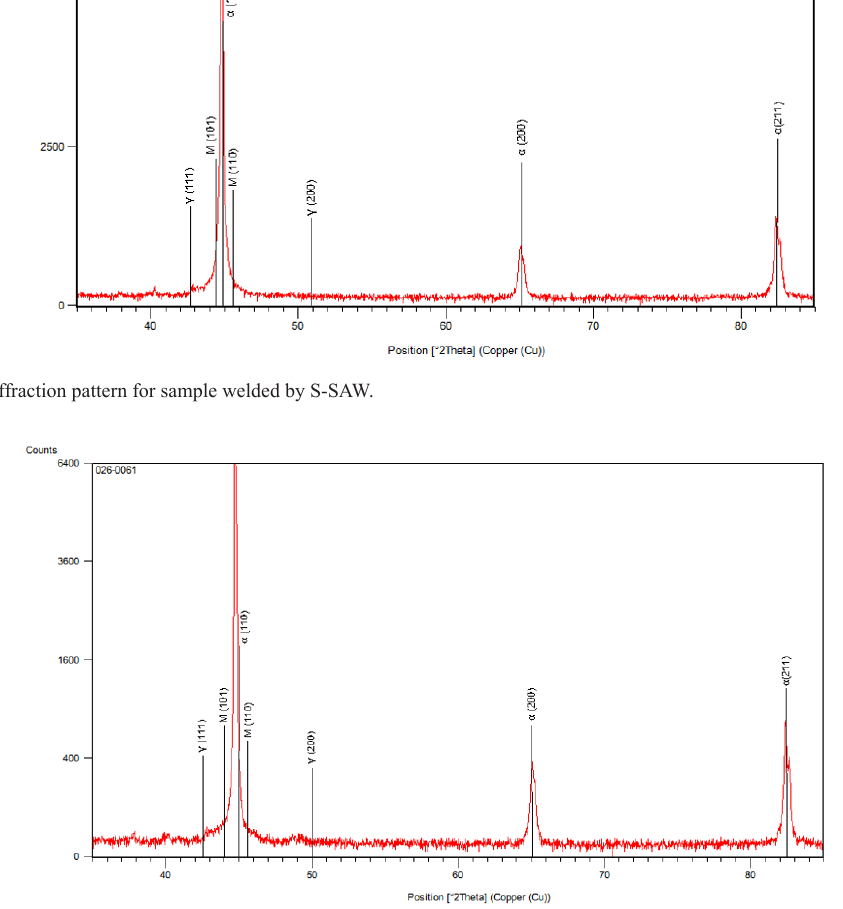
Figure 11: Diffraction pattern for sample welded by T-SAW. Table 9: Crystal parameters for the identified phases by X-ray diffraction.